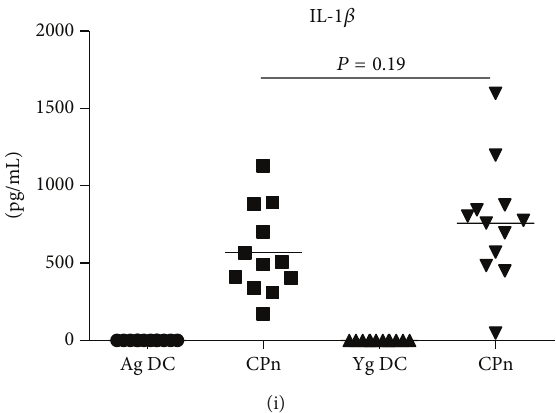
Figure2:AlteredsecretionofcytokinesandchemokinesbyDCsfromagedsubjectsascomparedtoDCsfromyoungsubjectsafterstimulation with CPn. Graphs depict the levels of cytokine and chemokines secreted by CPn-stimulated DCs from aged and young subjects. (a) CXCL-10; (b) TNF- 𝛼 ; (c) IL-12; (d) IL-10; (e) IFN- 𝛼 ; (f) IFN- 𝜆 ; (g) IL-6; (h) CXCL-8; (i) IL-1 𝛽 . Each dot corresponds to a separate subject. Data is of 13 aged and 13 young subjects. 𝑃 value depicted is comparison of CPn-stimulated DCs from aged subjects with their young